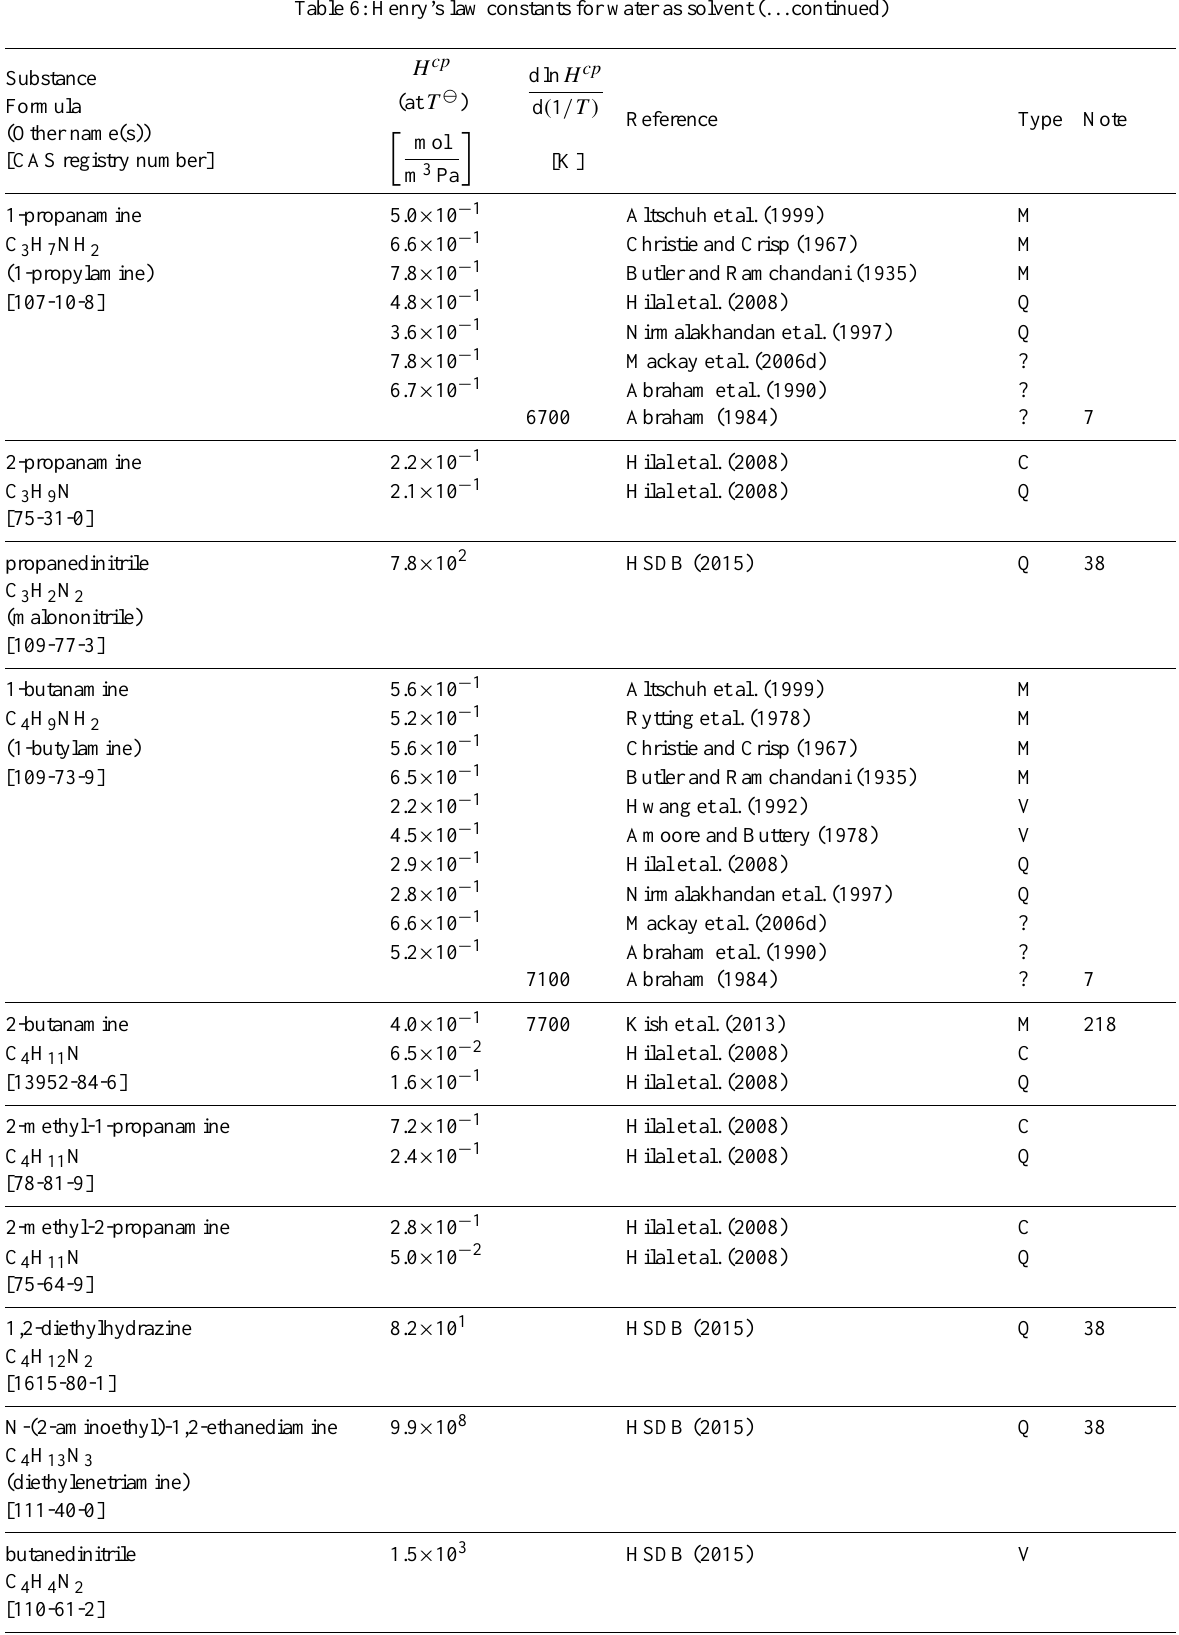
Table 6: Henry’s law constants for water as solvent